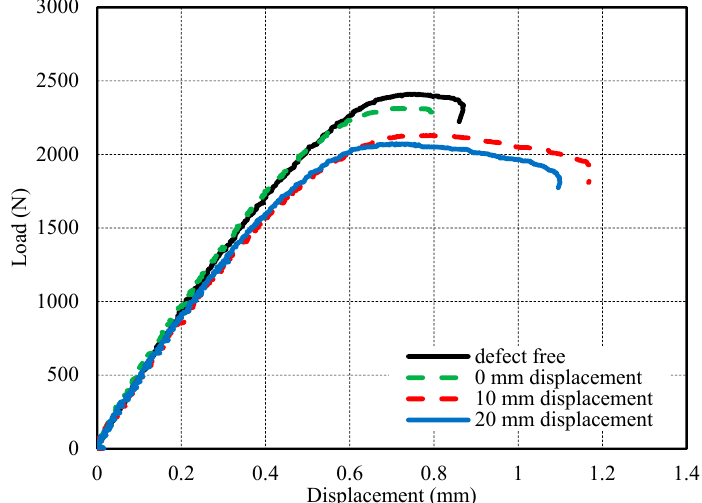
Figure 8. Load-displacement curves for the gray set specimens with different defect locations from the sample center.